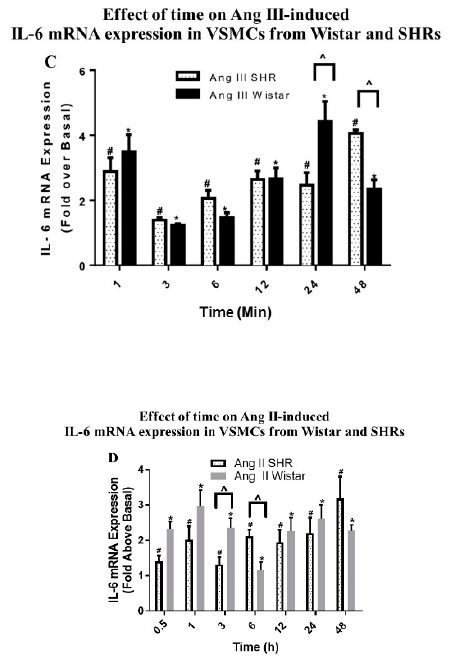
Figure 6. E ff ect of time on Ang II- and Ang III-induced IL-6 mRNA expression in Wistar and SHR VSMCs. Quiescent VSMCs isolated from ( A ) Wistar rats treated with Ang II or Ang III, and ( B ) SHRs treated with Ang II or Ang III were incubated with 100 nM Ang II or 100 nM Ang III for 1 h to 48 h. Panel ( C ) compares Ang III-mediated IL-6 mRNA expression from Wistar and SHR VSMCS. Panel ( D ) compares Ang II-mediated IL-6 mRNA expression from Wistar and SHR VSMCs. IL-6 mRNA expression was analyzed by quantitative PCR. The amount of Ang II- and Ang III-stimulated IL-6 mRNA expression was calculated as the fold-increase above basal. Each value represents the mean ± SEM of preparations of VSMCs isolated from four or more Wistar rats or SHRs. * Denotes p < 0.05 as compared to basal levels of IL-6 mRNA expression in Wistar VSMCs treated with Ang III or Ang II. # Denotes p < 0.05 as compared to basal levels of IL-6 mRNA expression in SHR VSMCs treated with Ang II or Ang III. ˆ Denotes p < 0.05 as compared between the e ff ects of Ang II or Ang III in stimulation of IL-6 mRNA expression in VSMCs isolated from Wistar rats versus SHRs.